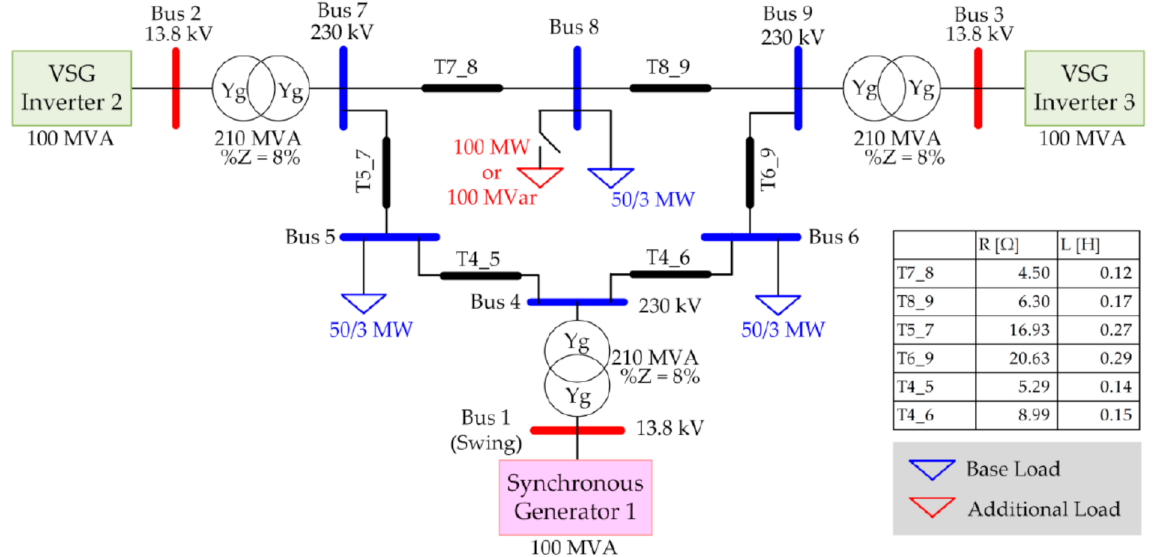
Figure 2. Connection diagrams of the Institution of Electrical and Electronic Engineering (IEEE) nine-bus